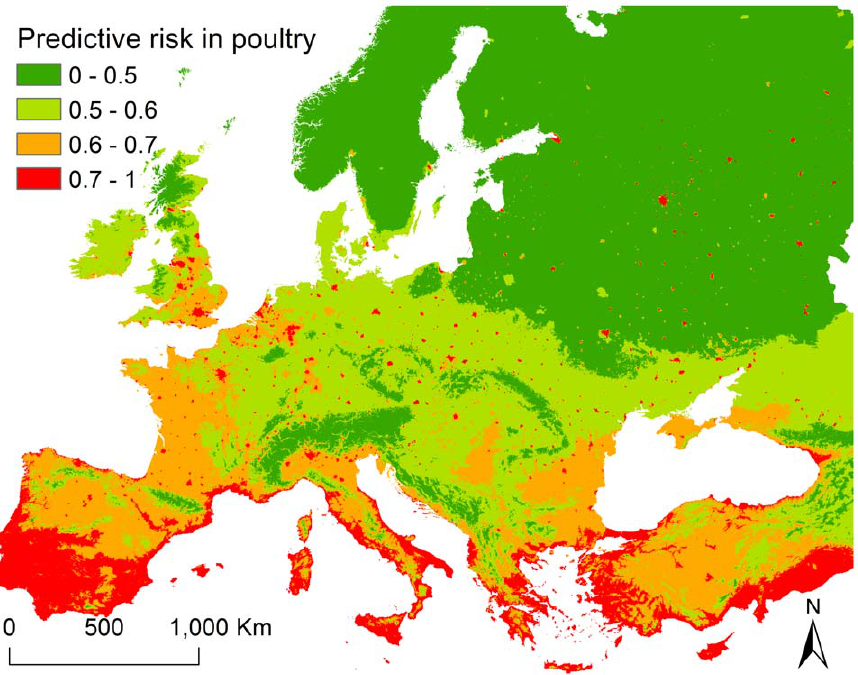
Figure 3. Predictive risk map of highly pathogenic avian influenza (HPAI) H5N1 outbreaks in poultry in Europe.